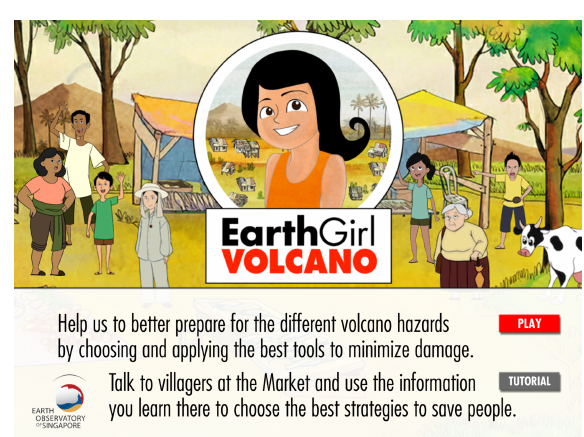
Figure 3. The welcome page encourages players to interact with members of the local